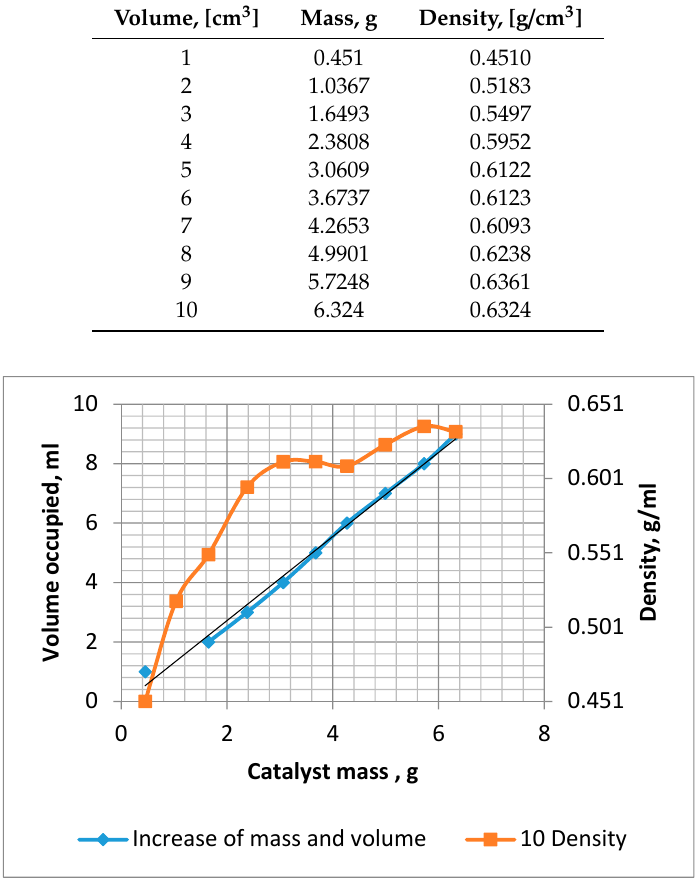
Figure 10. Volume occupied by the mass of active allophane particles in a 10 mL test tube.